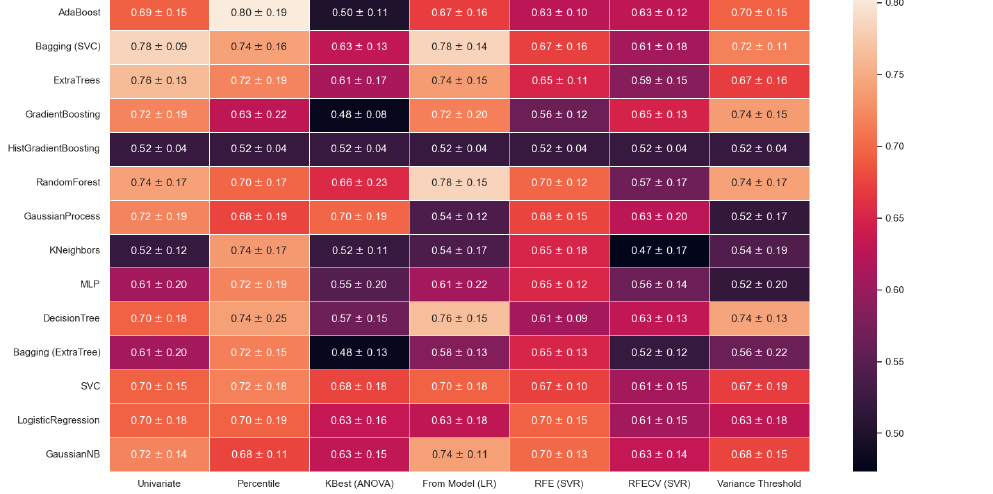
Figure 5. Accuracy values with a 5-fold